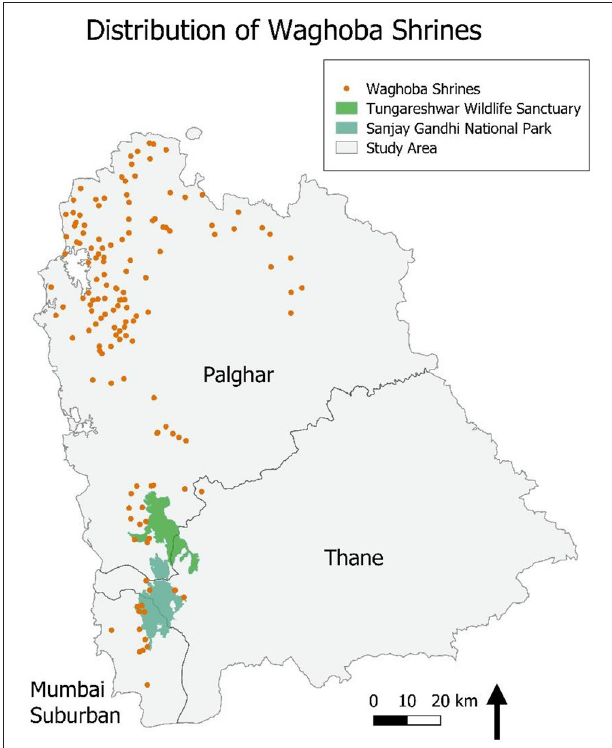
FIGURE 2 | Distribution of the 150 Waghoba shrines documented across the study